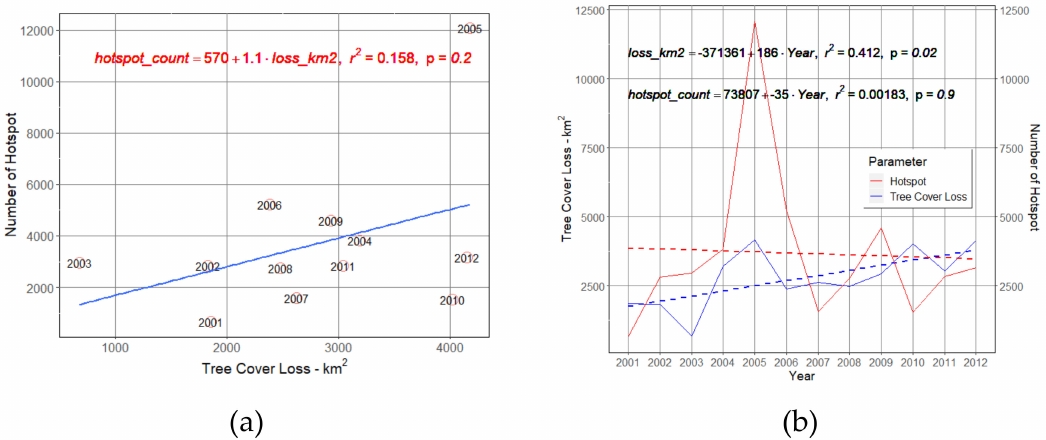
Figure 2. ( a ) Relationship between annual number of hotspots and tree cover loss in Riau Province; ( b ) Annual tree cover loss (blue lines, left axis) and number of fire hotspots (red lines, right axis) in Riau. The solid lines represent actual number and the dashed lines show the estimated linear trend lines. The equation of the best fit line and the correlation coe ffi cient ( r 2 ) is